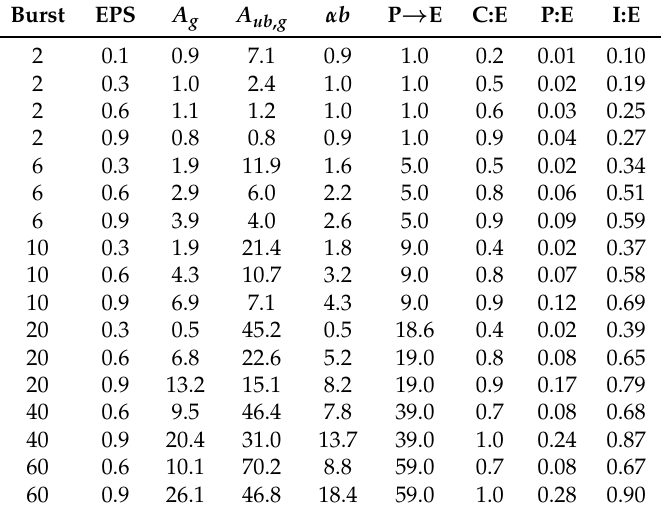
Table 2. Spatial grid model outcomes with random placement of EPS, no superinfection or debris. Burst EPS A g A ub ,